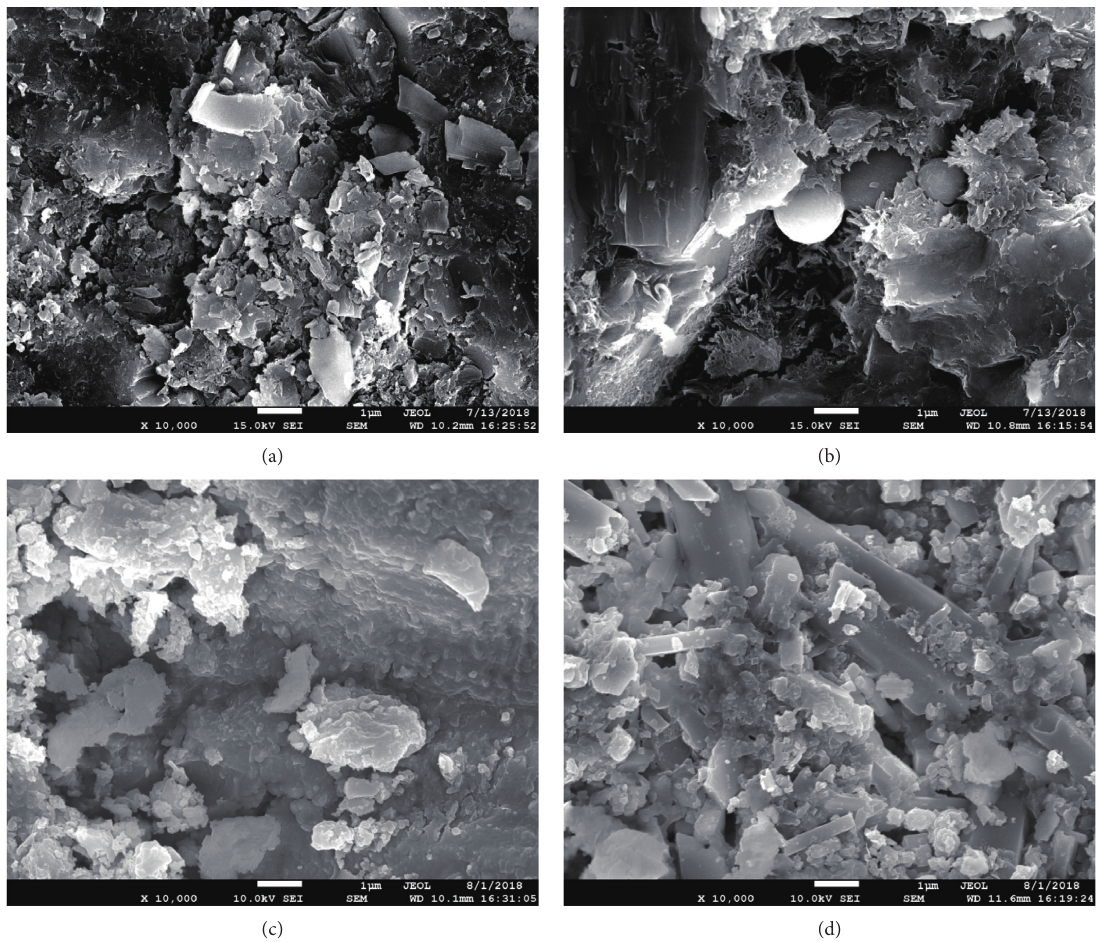
Figure 5: SEM images of different concretes: (a) JZ at 7 d; (b) NC at 7d; (c) JZ at 28d; (d) NC at